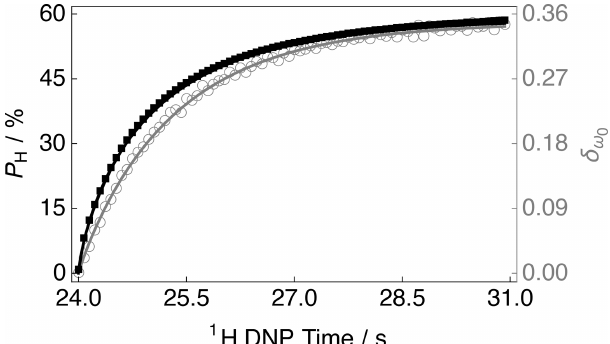
Figure 4. Experimental 1 H polarization P H DNP build-up curve (black filled squares and left-hand axis) and 13 C NMR peak CoG normalized deviation δ ω (grey empty circles and right-hand axis) 0 as a function of the 1 H DNP time acquired at 7.05T ( 1 H nu- clear Larmor frequency = 300.13MHz, 13 C nuclear Larmor fre- quency = 75.47MHz) and 1.2K with a single transient per data point for the case of positive microwave irradiation. The timings coincide with those shown in Fig. 2. The black solid line indicates the best fit of the experimental data points for the 1 H polarization P H DNP build-up curve, and has the corresponding fitting func- tion: A (1 − exp {− ( t/τ ± ) β } ). Mean 1 H DNP build-up time con- DNP (cid:68) (cid:69) = 80 . 2 ± 0 . τ ± stant DNP